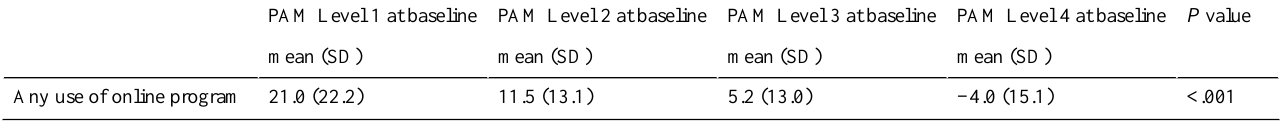
Table 6. PAM a score changes among those responding to